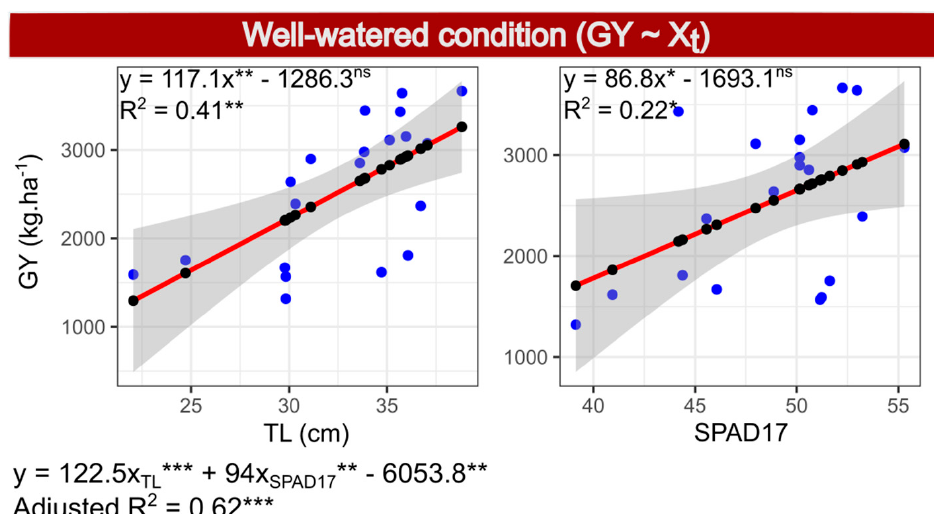
Figure 3. Simple linear regressions (within boxes) and multiple regressions (below the boxes) between the dependent variable grain yield (GY) and independent variables tassel length (TL) and SPAD index, measured 17 days after anthesis (SPAD17) and evaluated in 20 popcorn inbred lines under well-watered conditions.